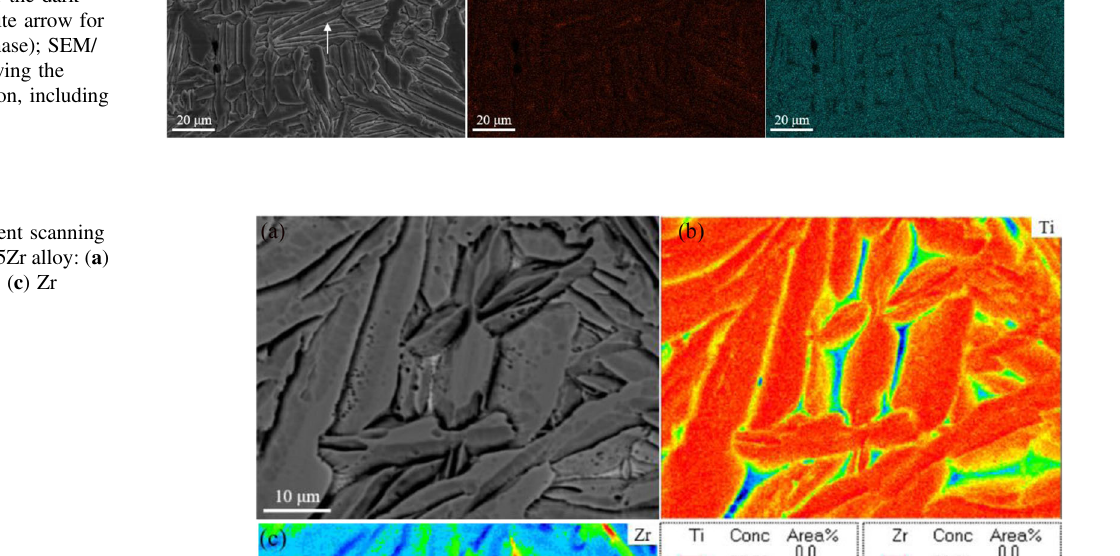
Fig. 3 a Backscattered SEM micrograph showing the microstructure of the Ti-45Zr alloy (red arrow for the dark lamellae phase, white arrow for the white needle phase); SEM/ EDS mapping showing the elemental distribution, including ( b ) Zr and ( c ) Ti